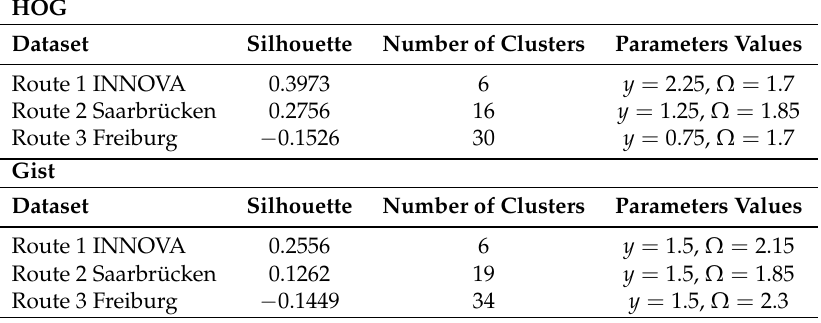
Figure 10. Results obtained with the gist descriptor for different values of y and Ω for the datasets ( a ) INNOVA, ( b ) Saarbrücken and ( c ) Freiburg. The first row of each subfigure shows the final number of clusters (colour mapped) and the second one the average silhouette (colour mapped) after the proposed incremental hierarchical mapping process. Table 2. Maximum silhouette obtained per configuration, showing also the number of clusters and the configuration of the